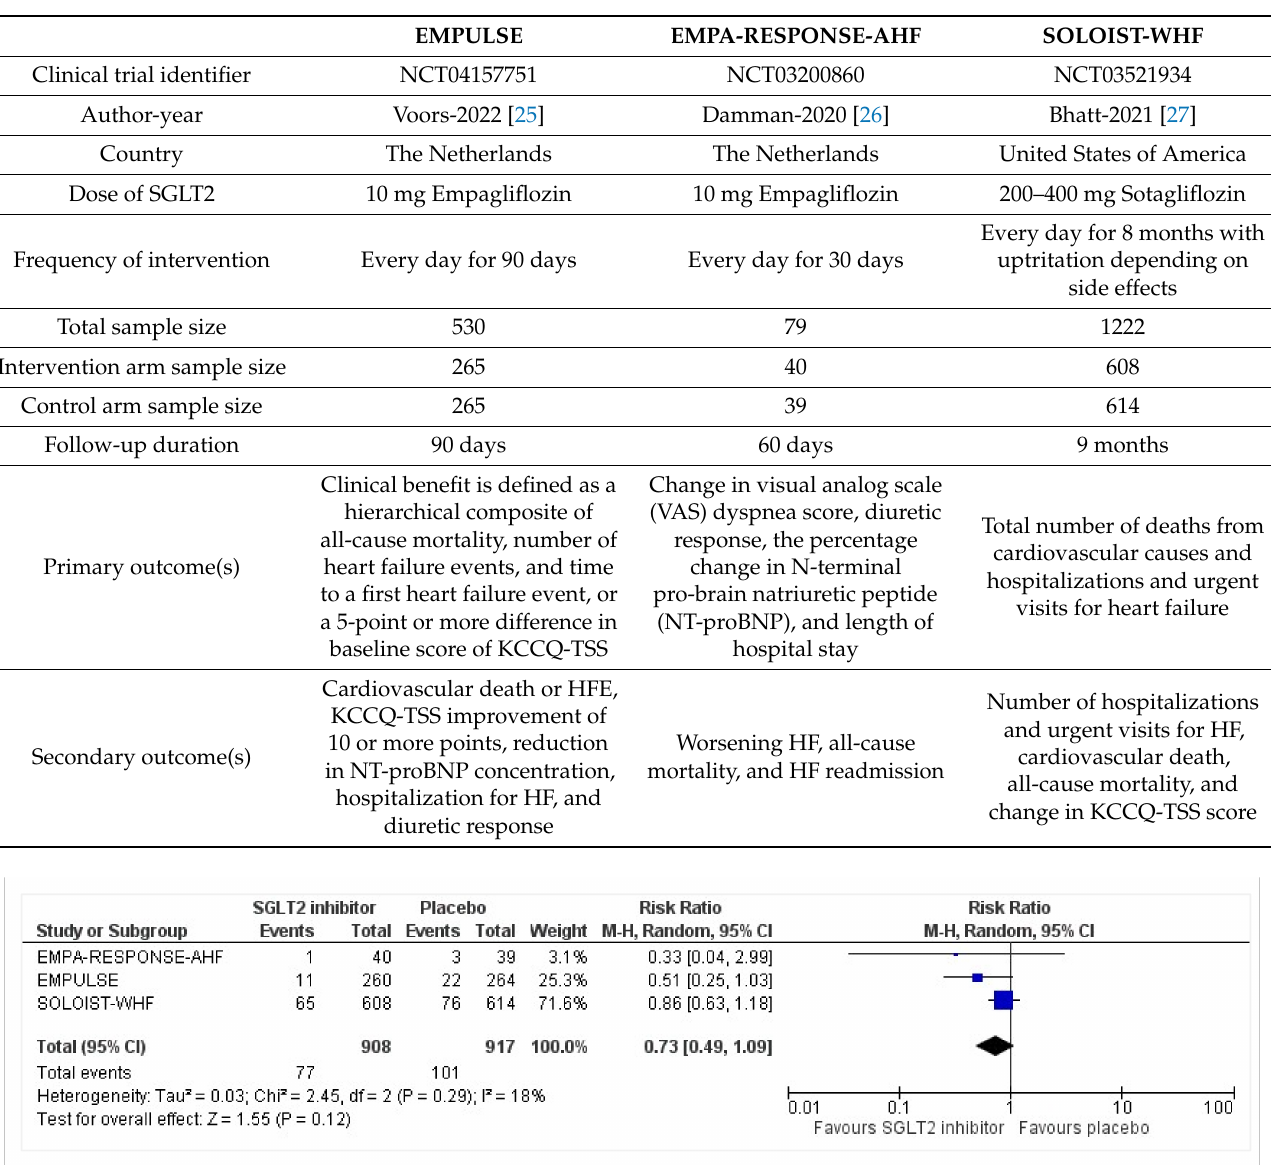
Figure 3. Forest plot for all-cause mortality of patients with acute heart failure receiving sodium- glucose cotransporter 2 inhibitor or placebo. The total number of events is presented in the given study duration [25–27]. CI: confidence interval; M-H: Mantel–Haenszel; SGLT2: